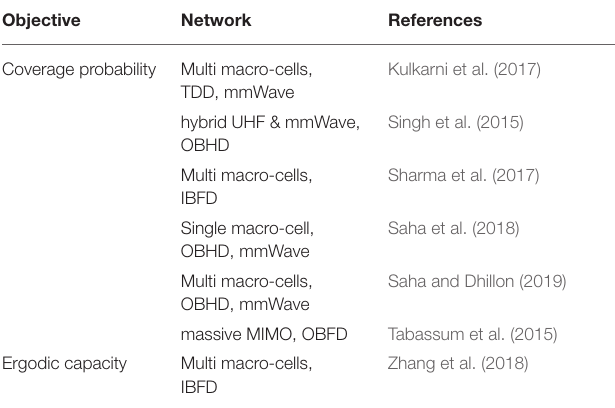
TABLE 1 | Taxonomy of literature in section 3.